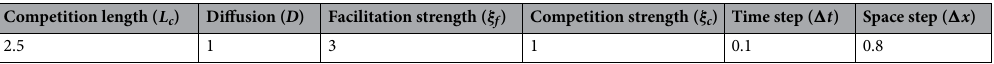
Table 3. List of parameter values of the simulations of the integrodifferential model, shown in Fig. 3b ( 512 × 512 grid, µ = 1.301 ), Fig. 4b ( 256 × 256 grid), and Fig. 5 ( 256 × 256 grid).